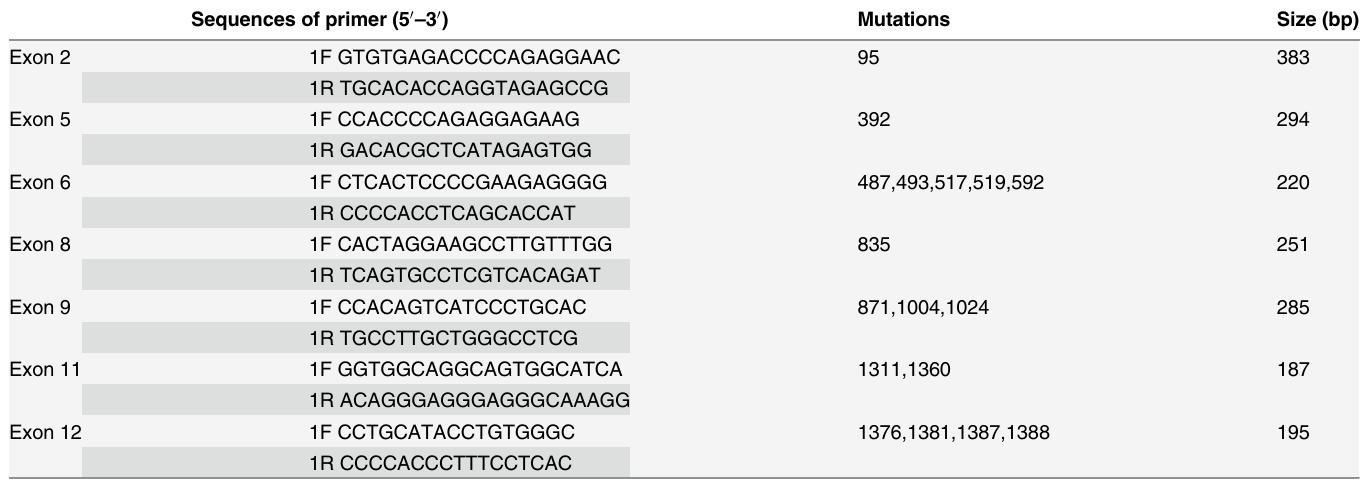
Table 1. Multiplex PCR